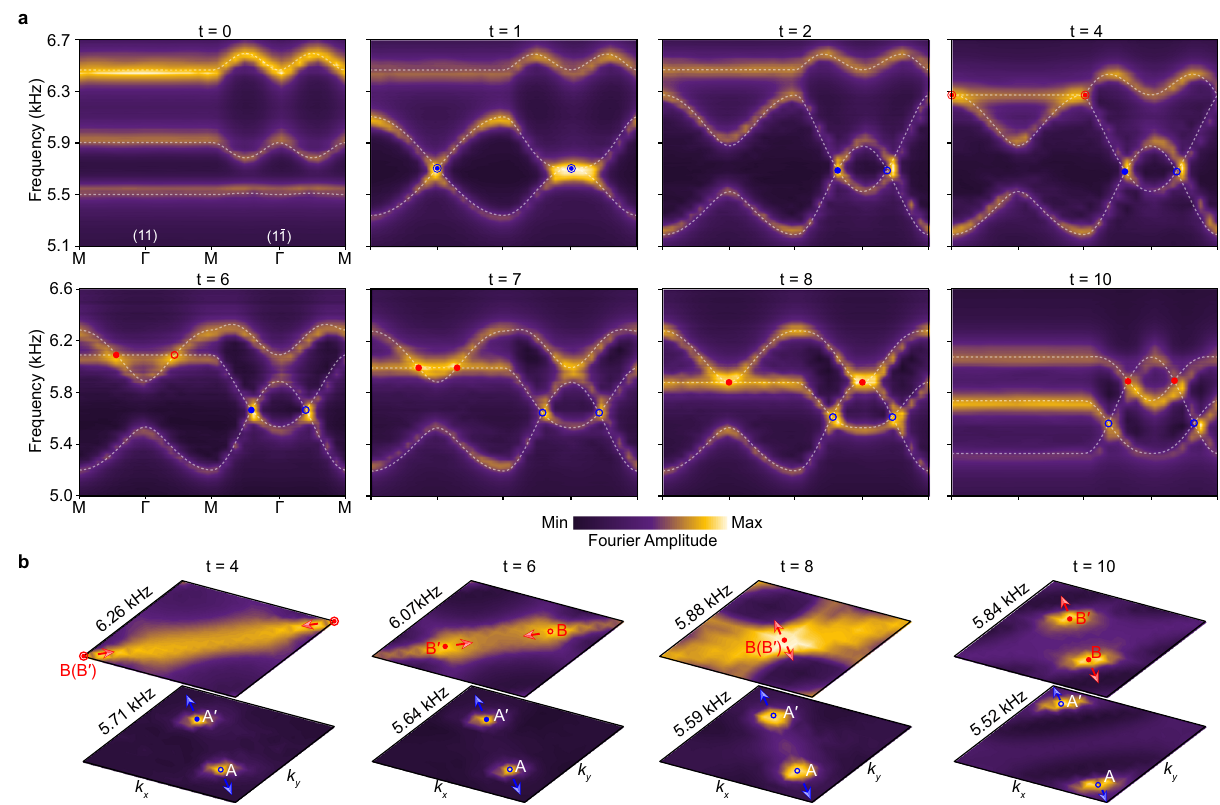
Fig. 3 | Experimental observation of non-abelian braiding of acoustic band nodes. a Measured bulk spectra along the HSLs for a sequence of acoustic meta- materials. All experimental data (color scale) excellently match the simulation